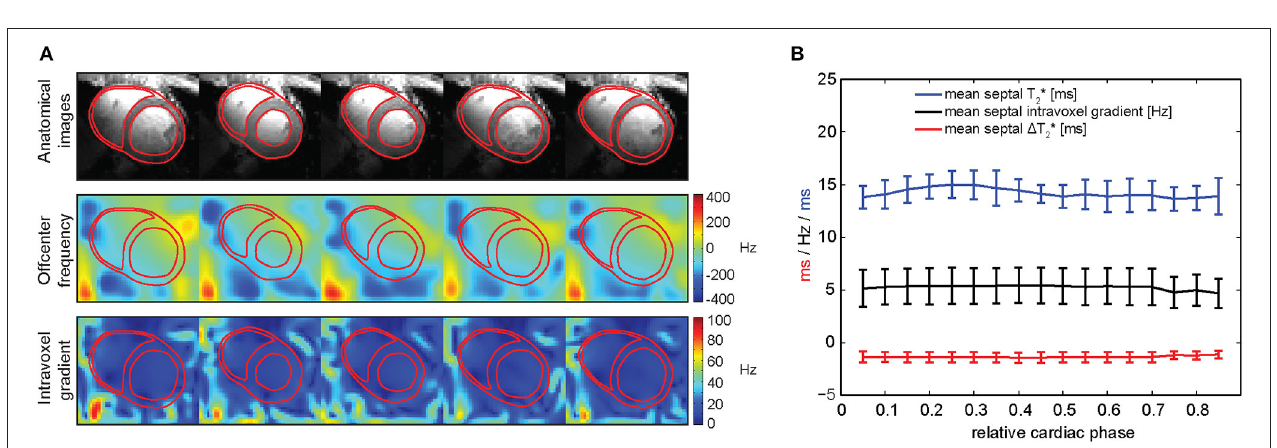
FIGURE 9 | Spatial and temporal variation of macroscopic intra-voxel B 0 gradients in the in vivo human heart. (A) Magnitude images of a short-axis view (top), in-plane macroscopic B 0 maps (middle) and intra-voxel macroscopic B 0 gradient maps (bottom) over the cardiac cycle. (B) Mean septal T 2 * (blue), intra-voxel B 0 gradient (black) and estimated 1 T 2 * caused by this B 0 gradient (red) over the cardiac cycle, averaged among a group of healthy volunteers. Temporal macroscopic magnetic field changes over the cardiac cycle are minor regarding their effects on T 2 * (from Huelnhagen et al. [84] with permission from John Wiley and Sons).